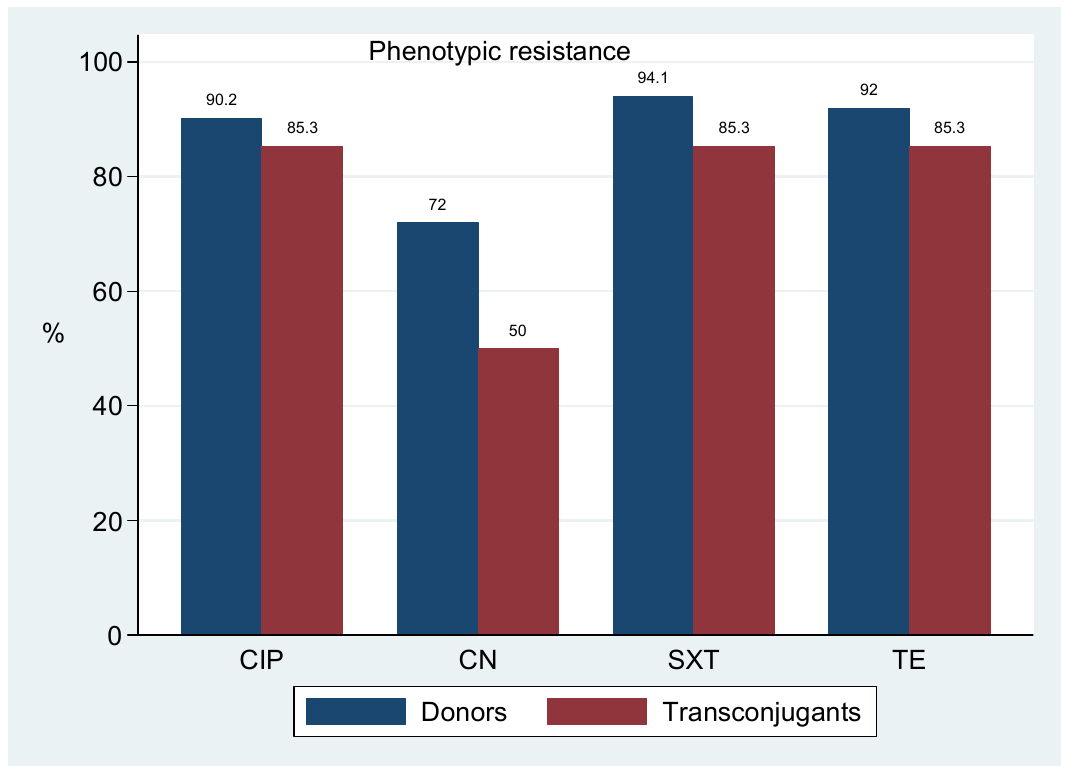
Figure 1: Transfer success of bla CTX-M-15 among E. coli isolates of human, animals and the environment.